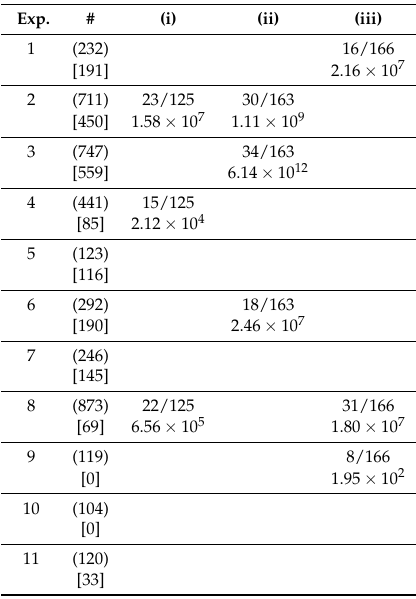
Table 6. In each of the 11 experiments, 20 top-ranked significant treatments with compounds whose sets of upregulated genes significantly overlap with the set of genes selected for each experiment were identified. Therefore, treatment with the following compounds is most frequently ranked within the top 20.